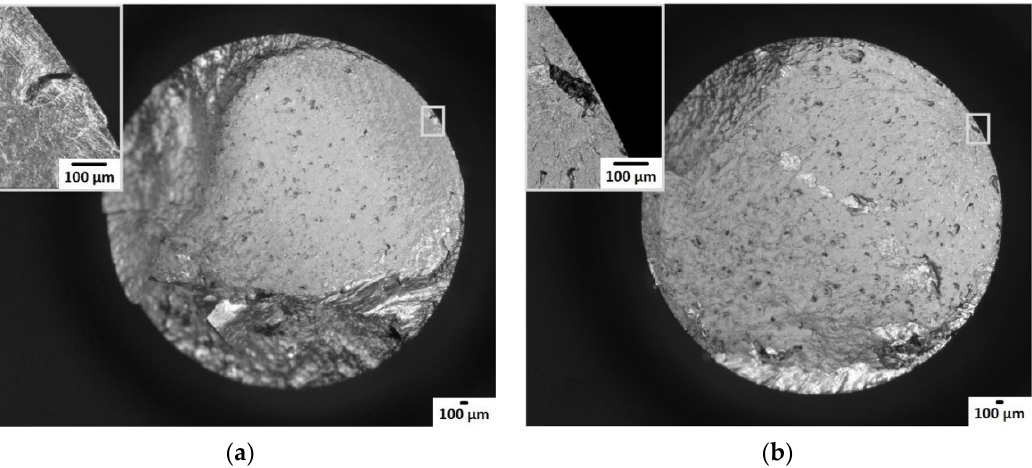
Figure 14. Digital optical microscope images of fatigue fracture surfaces (30× and 300×). ( a ) Surface defect; ( b ) sub-surface defect. Table 4. Summary of features and their characteristics observed at crack initiation sites.